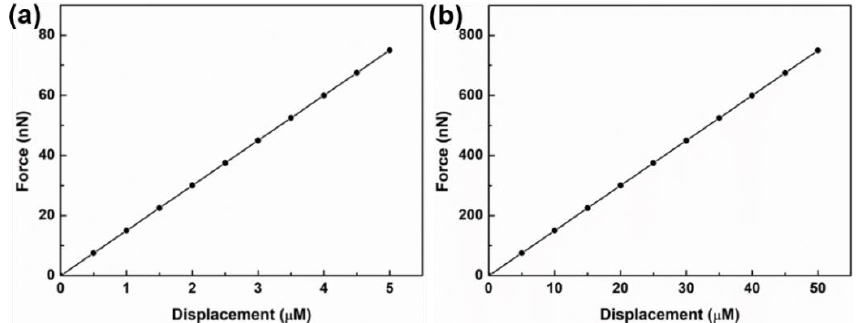
Figure 3. ( a , b ) Measurement of force as a function of cantilever displacement.